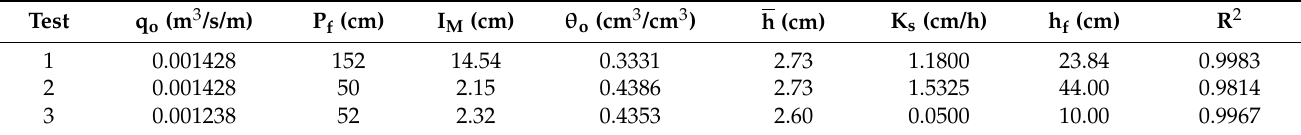
Table 1. Values of the initial conditions in three irrigation